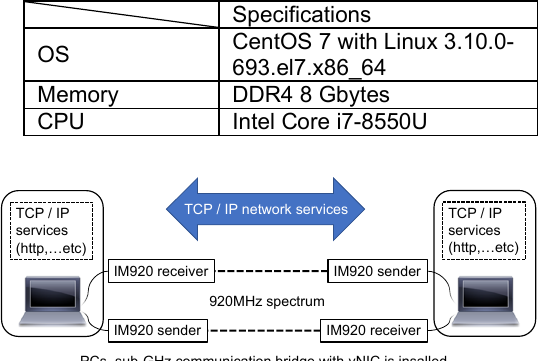
Figure 4. Implementation of proposed communication bridge using IM920 with two PCs.